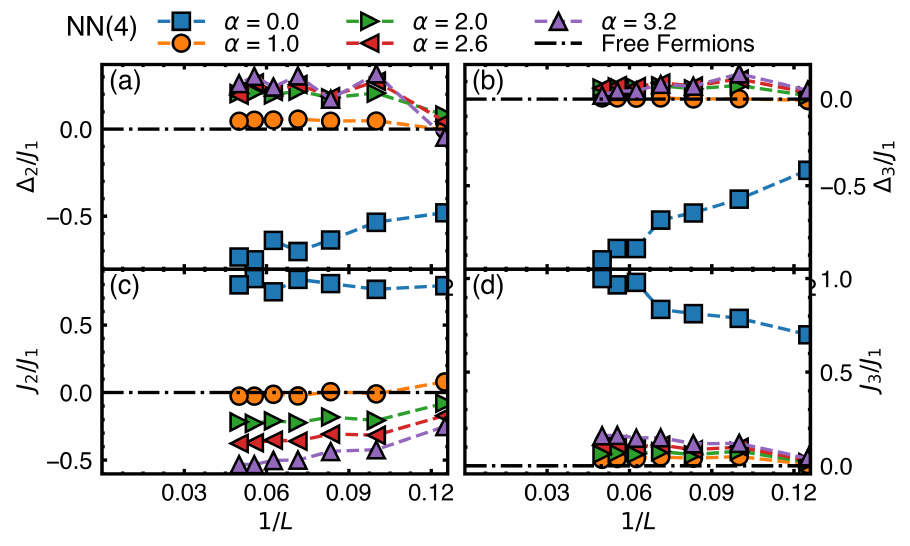
Figure 9: Ratios of the converged couplings ∆ size. We see that α = 1 is flowing toward the XX Hamiltonian (see also Fig. 6), while the other converged values are stationary in non-null values, suggesting long range 2-body physics for the JG states.